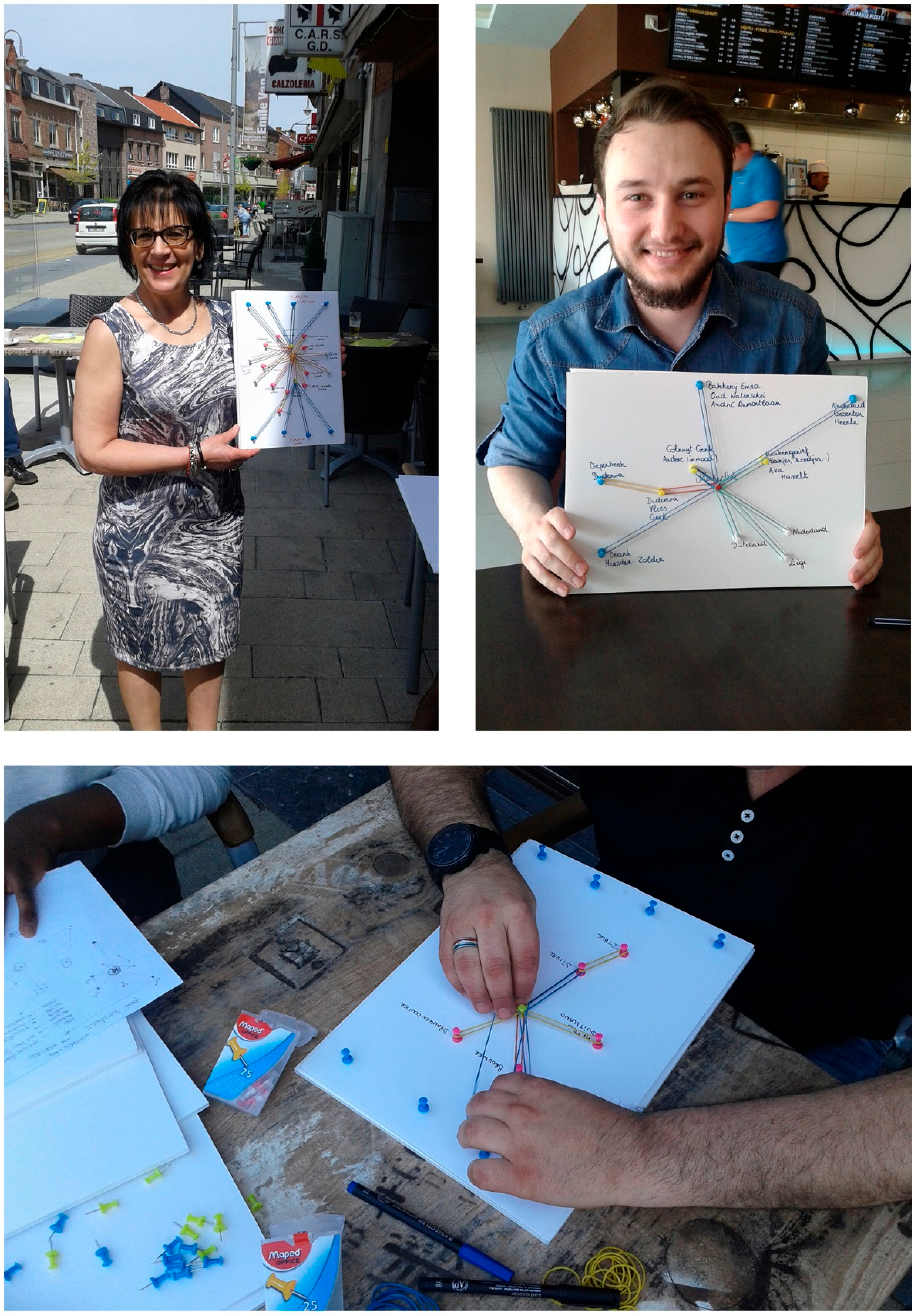
Figure 2. Visual Figure 2. Visual portraits.